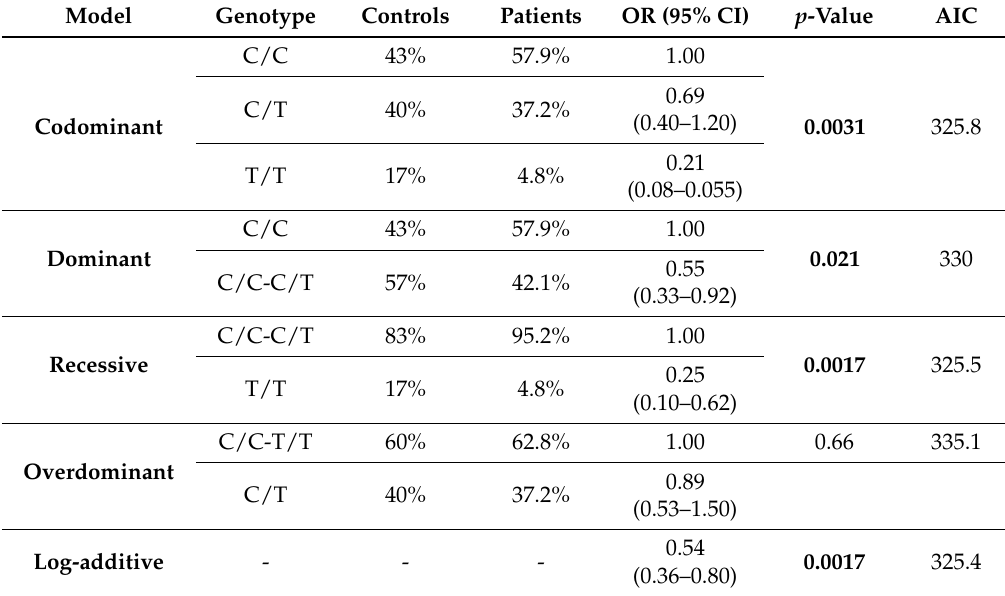
Genotype frequencies, inheritance models and calculated Odds Ratios for CD14 polymorphism